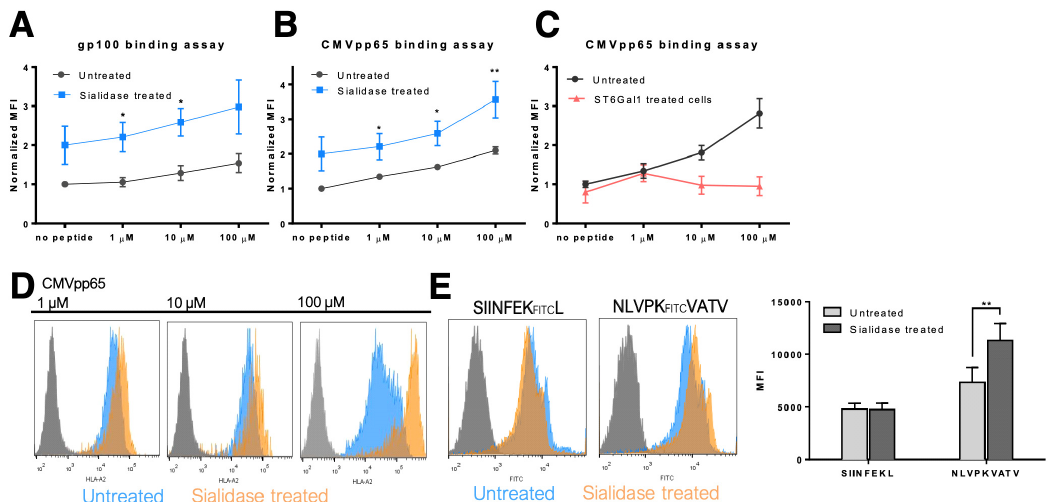
Figure 4. MHC class I molecules stability at cell surface after desialylation. T2 cells were used to study MHC-I stability after sialic acid removal from cell membrane. T2 cells were incubated with either ( A ) gp100 peptides or ( B ) CMVpp65 peptides, which match the HLA-A*02:01 pocket and stabilize the peptide-MHC-I- β 2 complex. Cells were then probed with anti-HLA-A*02 antibody (BB7.2) and analyzed by flow cytometry. ( C ) T2 cells were extrinsically sialylated with a recombinant ST6Gal-I enzyme and incubated with the CMVpp65 peptide. Cells were then probed by flow cytometry for HLA-A*02 (using the BB7.2 antibody) expression at the cell surface. Graphs show normalized mean fluorescent intensity (MFI) values of at least 4 independent experiments. ( D ) Representative flow cytometry histograms of T2 cells untreated (in blue) or after sialidase treatment (in orange) and incubated with di ff erent concentrations of CMVpp65 peptide. ( E ) The fluorescently labeled NLVPK FITC VATV peptide was used to stain HLA-A2 on desialylated T2 cells and the fluorescently labeled SIINFEK FITC L peptide was used as irrelevant control. The quantification of the mean fluorescence intensity of fluorescently labeled peptides presented by T2 cells is also presented. Values presented are mean ± SD of at least N = 4 independent experiments. Statistically significant di ff erences are indicated by asterisks (* p ≤ 0.05, ** p ≤